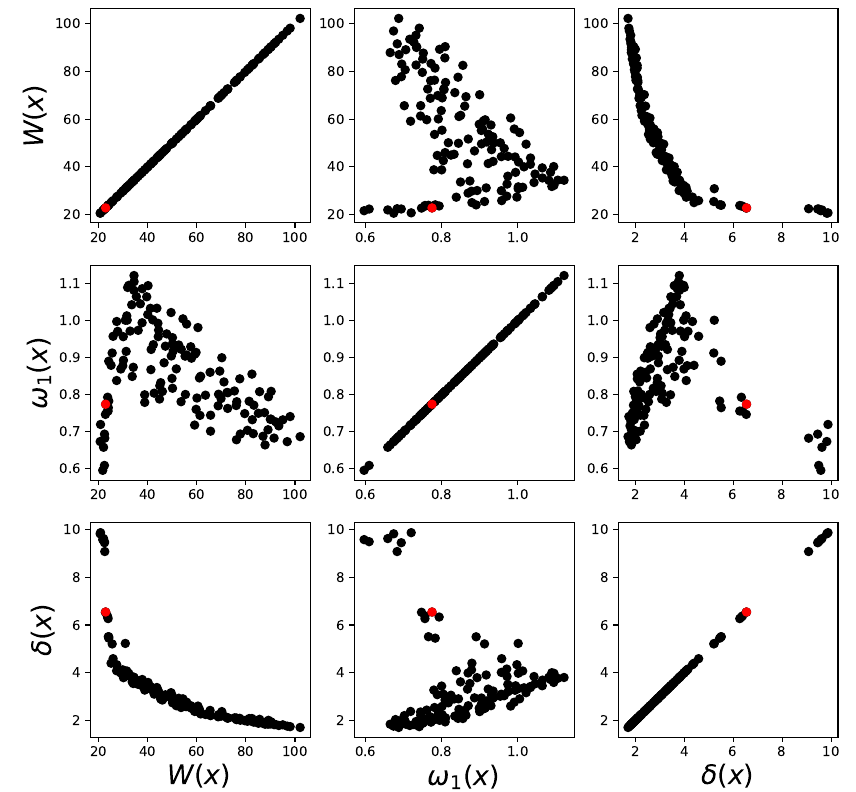
Figure 12. Scatter plot of the PF obtained for MOSOP2.